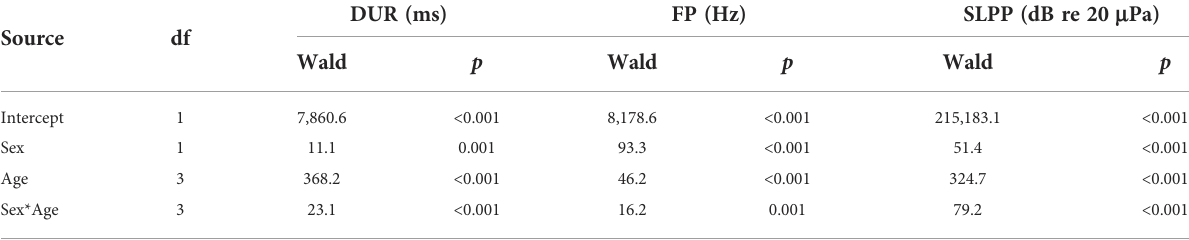
TABLE 2 Results of a generalized linear model analysis on the sound parameters of duration (DUR), peak frequency (FP), and peak-to-peak source level (SLPP) for different spotted seal pup groups.